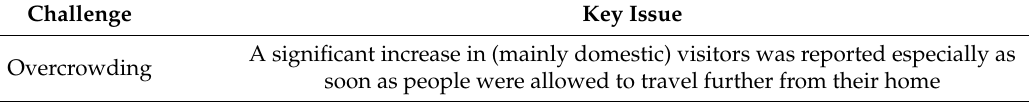
Table 2. Challenges in managing European PAs due to COVID-19.